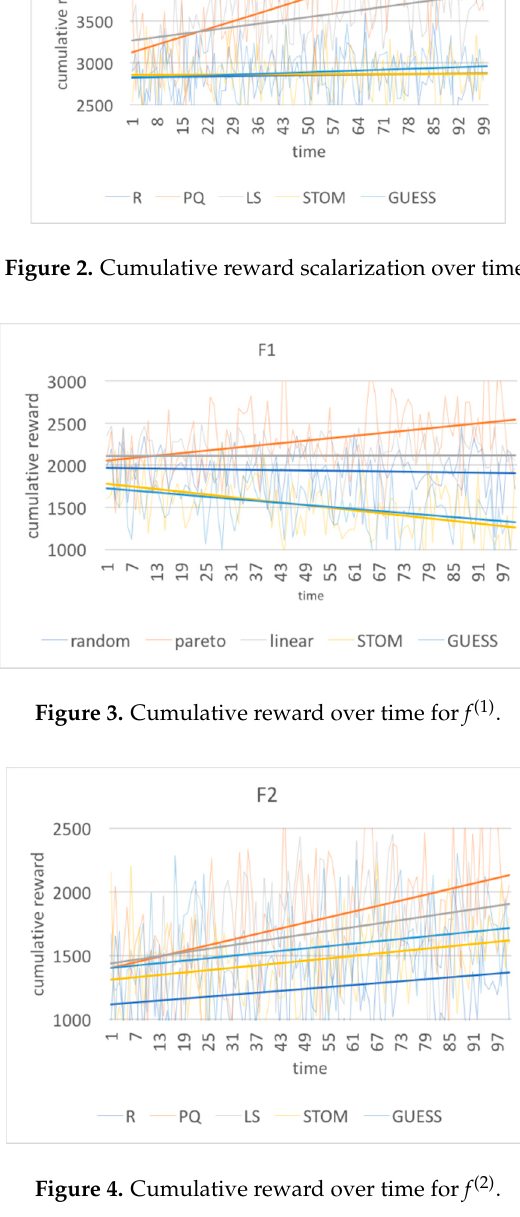
Figure 5. Cumulative reward over time for f (3) .